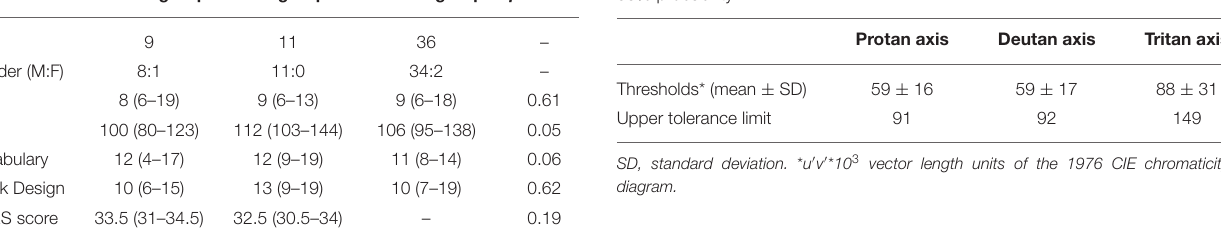
TABLE 1 | Background characteristics of the groups. TABLE 2 | Color discrimination thresholds obtained by the control group ( n = 41) and respective upper tolerance limits calculated for 90% of the population with 90% probability.